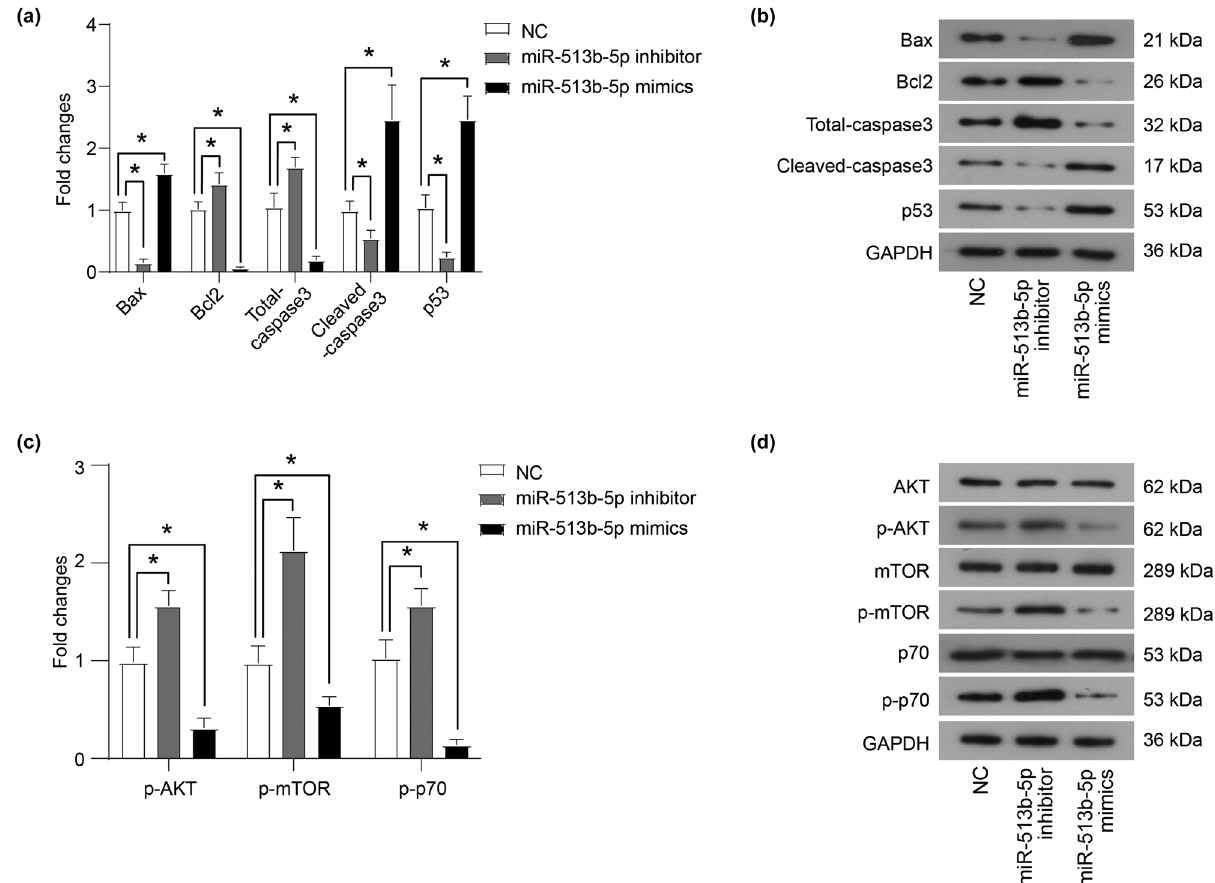
Figure 2: miR - 513b - 5p inhibits the activation of the AKT/mTOR signaling pathway. ( a and b ) The protein expression of key proteins related to apoptosis was measured using a western blot. ( c and d ) The protein expression of key proteins in the AKT/mTOR signaling pathway was measured using western blot. The di ff erences were evaluated using the Mann – Whitney U - test for pair - wise comparisons. * P < 0.05. Each group of ( b and d ) includes three samples. All experiments were repeated three times independently, and the individual experiments were performed 1 week